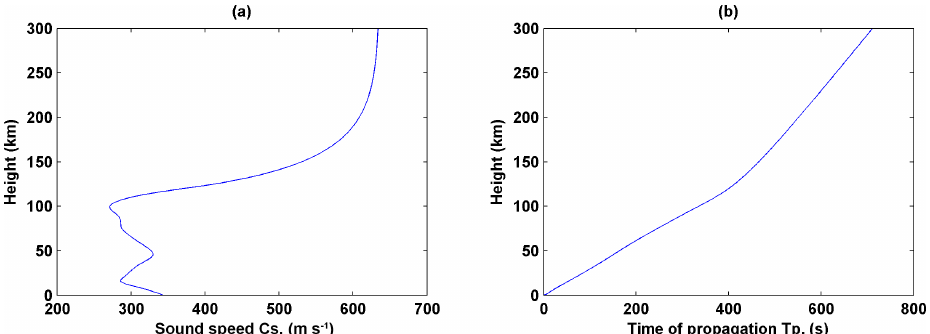
Figure 3. (a) Infrasound propagation speed as a function of height. (b) Time required by infrasound to propagate from surface to various heights.